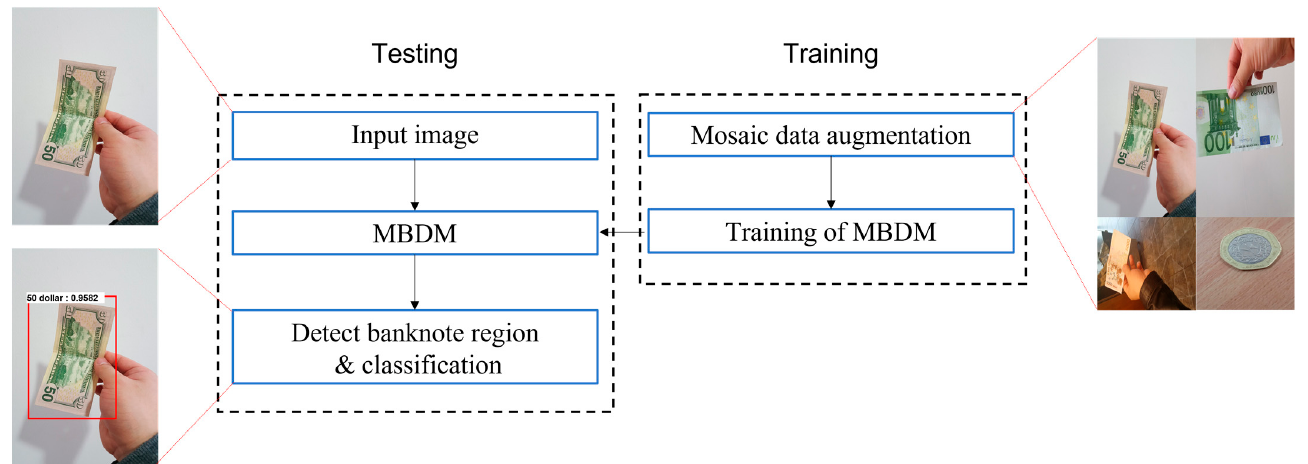
Figure 1. Procedure of proposed method for multinational banknote detection.